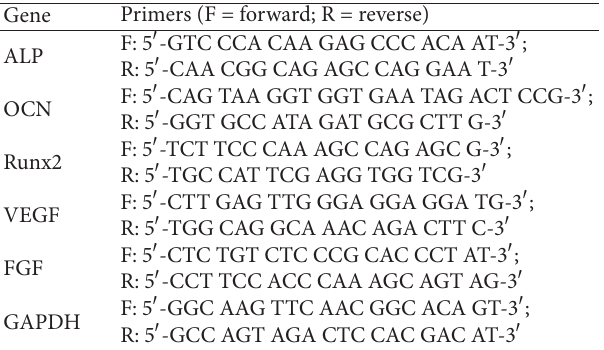
Table 1: Primer sequences for real-time quantitative polymerase chain reaction analysis of the expression of osteogenic genes (Runx2, alkaline phosphatase (ALP), and osteocalcin (OCN)) and angiogenic genes (vascular endothelial growth factor (VEGF) and fibroblast growth factors